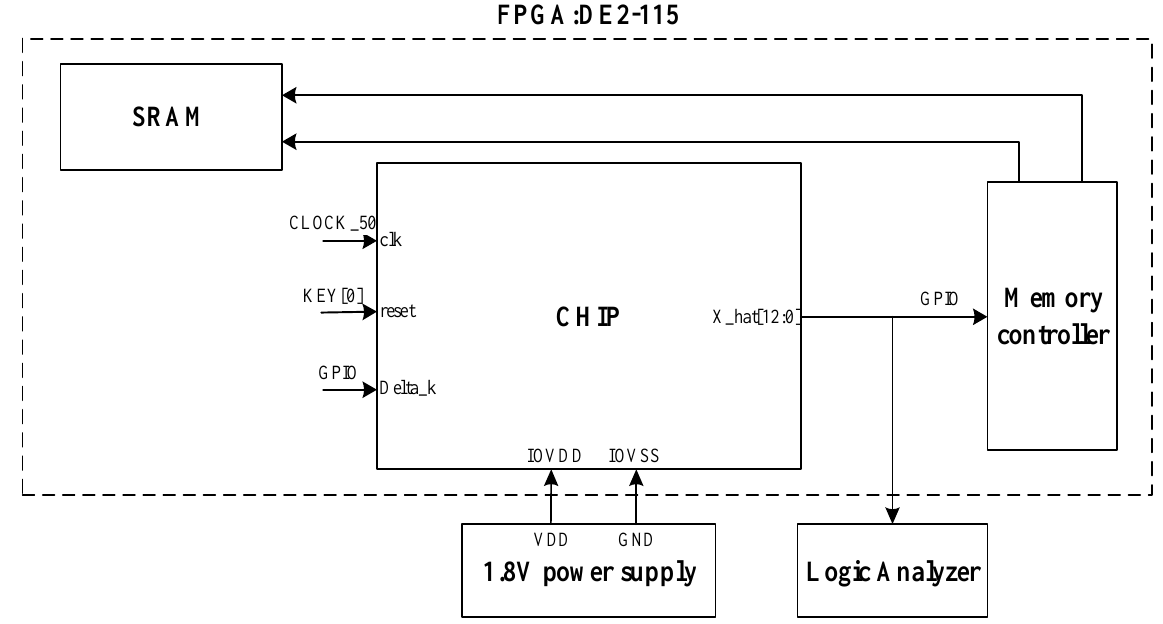
Figure 16. Architecture of measurement environment on FPGA.